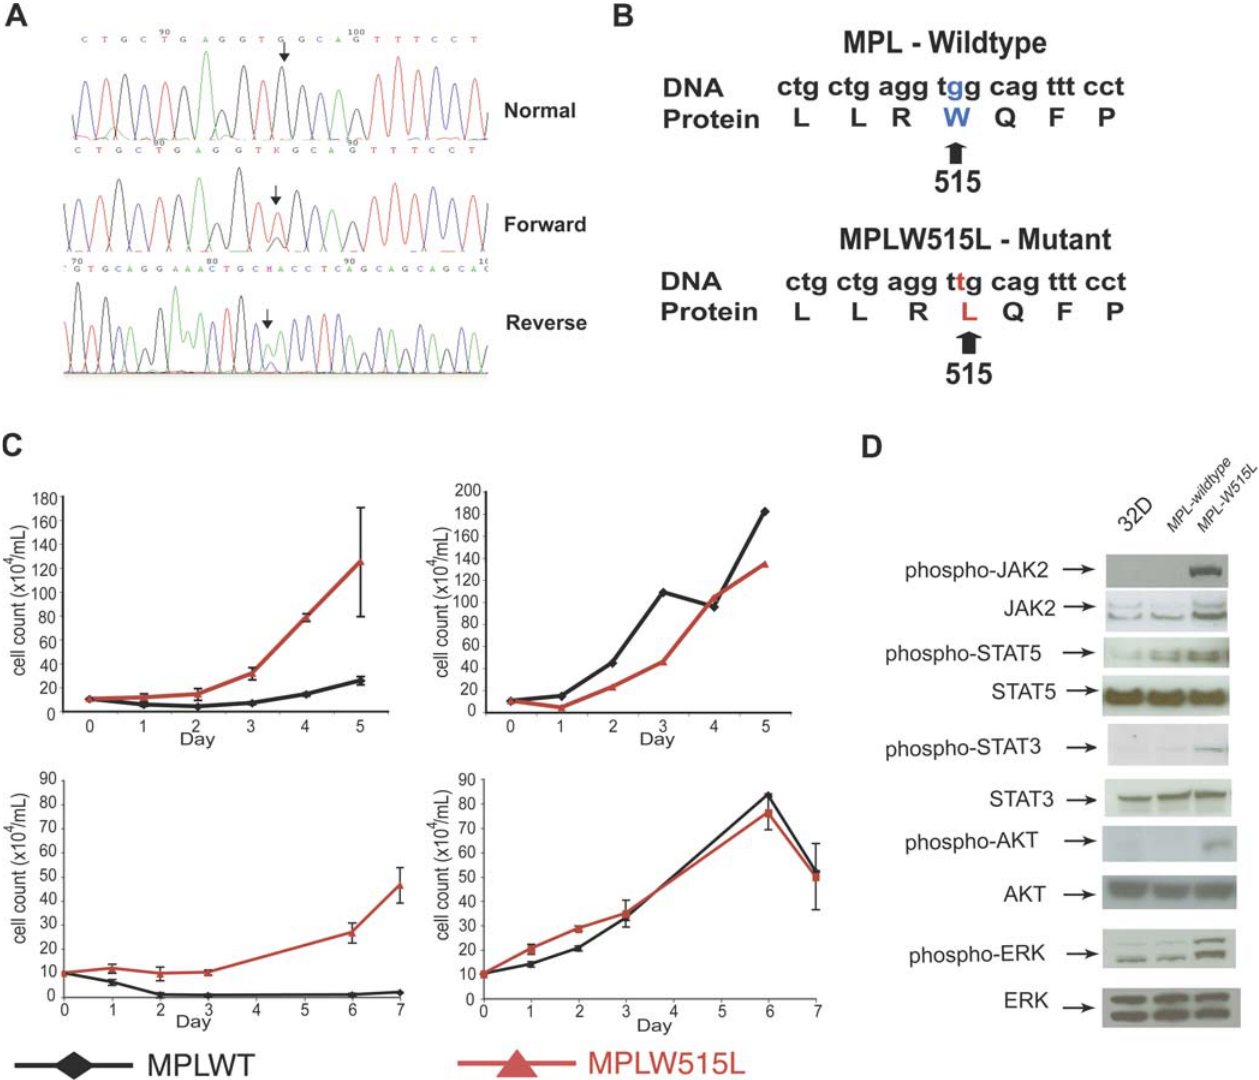
Figure 1. MPLW515L Mutation Is Found in JAK2V617F-Negative MF and Causes Cytokine-Independent Growth in 32D and UT7 Cells, and Constitutively Activates the JAK-STAT Signaling Pathway (A) Forward (middle trace) and reverse (lower trace) sequence traces demonstrating a heterozygous guanine to thymine substitution (arrows) present in granulocyte DNA from a patient with MF. The mutation is not present in buccal DNA from the same patient (upper trace). (B) DNA sequence and protein translation for both the wild-type and mutant MPL alleles. The mutation results in a tryptophan-to-leucine substitution at codon 515. (C) Upper: 32D cells transduced with MPLW515L exhibit cytokine-independent growth compared with MPLWT (left). Cell lines grown in the presence of IL3 show equal rates of growth (right). Error bars denote the standard deviation for each sample measured in triplicate. Lower: UT7 cells transformed with MPLW515L exhibit cytokine-independent growth compared with MPLWT (left). Cell lines grown in the presence of TPO (5 ng/mL) show equal rates of growth (right). Error bars denote the standard deviation for each sample measured in triplicate. (D) 32D cells, 32D MPLWT cells, and 32D MPLW515L cells were deprived of cytokines and then analyzed by Western blots, demonstrating phosphorylation of JAK2, STAT5, STAT3, AKT, and ERK in MPLW515L compared with